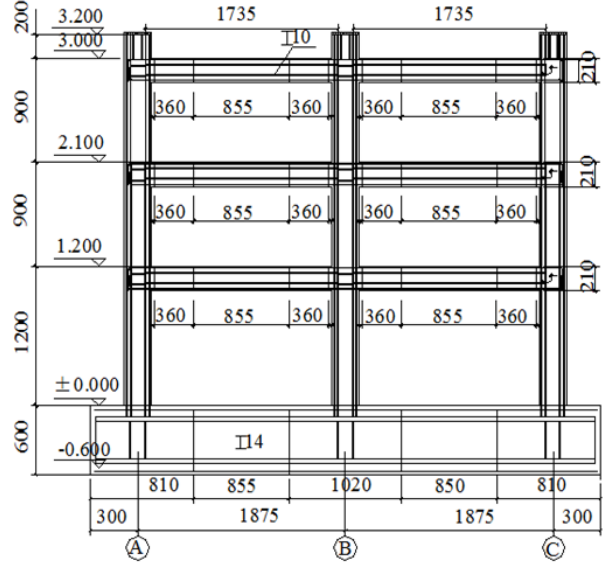
Figure 4. Elevation of SRHPC frame and cross ‐ sectional drawing of beams and columns (unit of length: mm; unit of elevation: m).